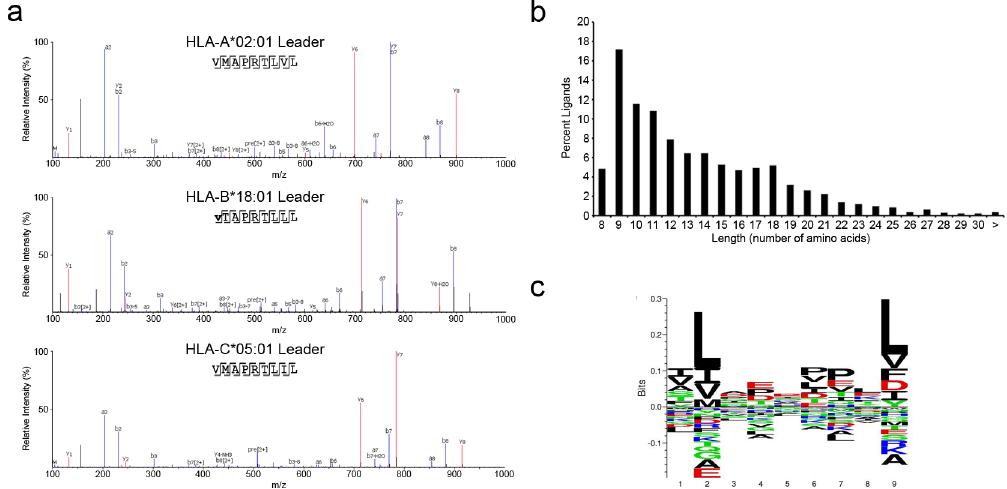
Fig 2. Class I leader peptides eluted from sHLA-E molecules. A) Representative annotated MS2 fragment ion spectra for the identifiedleaderpeptidesfrom HLA-A * 02:01, HLA-B * 18:01,and HLA-C * 05:01 that were eluted from purifiedsHLA-E. B) Lengthdistributionof all non-redundant HLA-E ligandsidentifiedcombinedfrom Mtb infected and uninfectedcells. C) Peptide bindingmotif of nonamerpeptidesequenceseluted from HLA-E. Motif was generatedusing